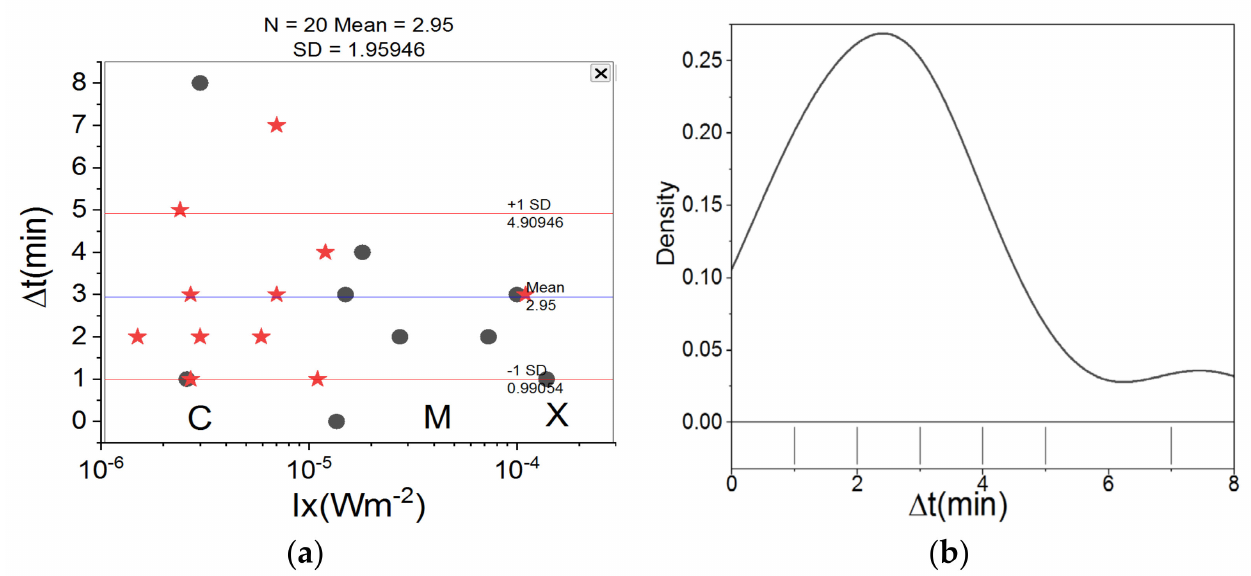
Figure 11. ( a ) The time delay ∆ t between the VLF amplitude max and the peak of SF X-ray flux as a function of peak flux (black circles are data from present investigation, red stars data from [27]; ( b ) Distribution of ∆ t data points (a rug